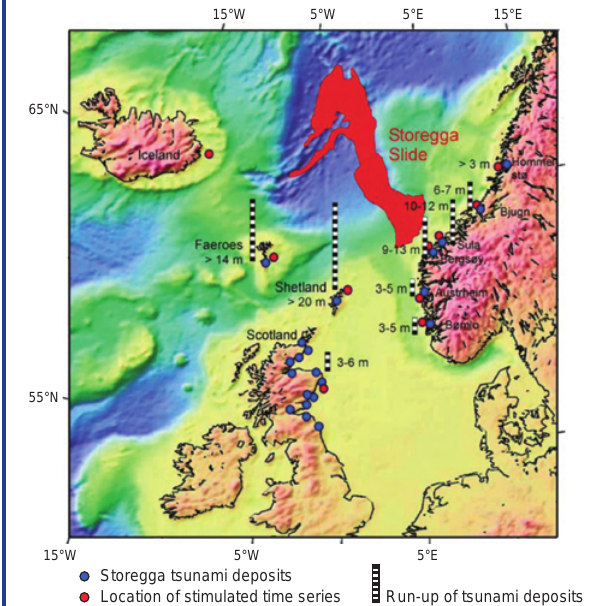
Figure 3. Map of the Storegga Slide off the Norwegian coast. Blue dots show where tsunami deposits have been studied. Numbers show elevation of the deposits above the contemporary sea level. Red dots show approximate position of the time series. Figure from Bondevik et al. (2005).